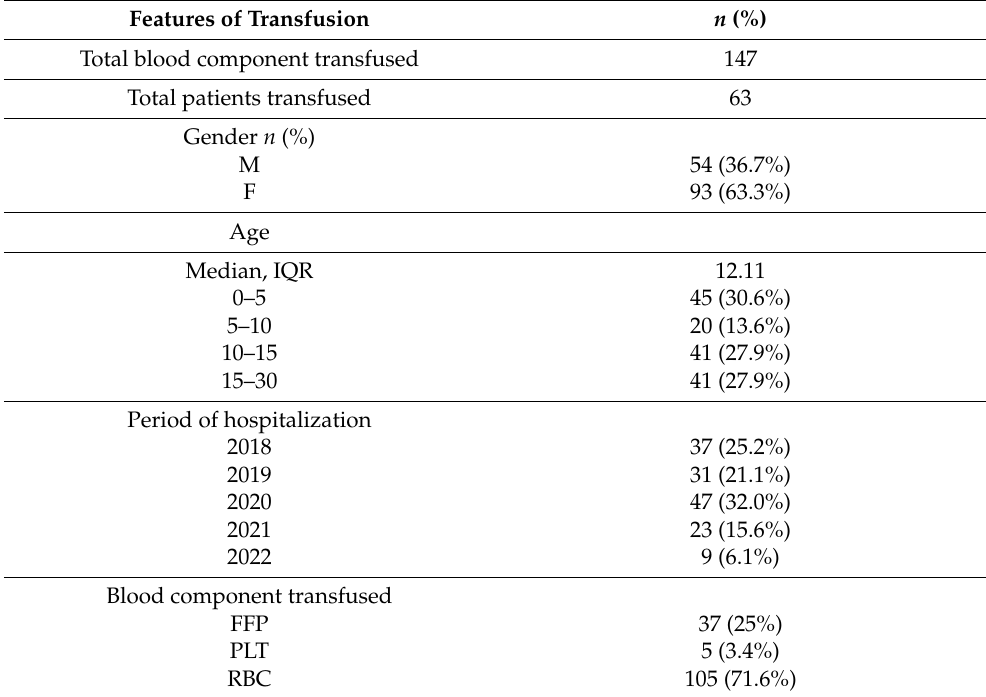
Table 1. Feature of the blood component transfusion ( n = 147) performed between 2018–2022.